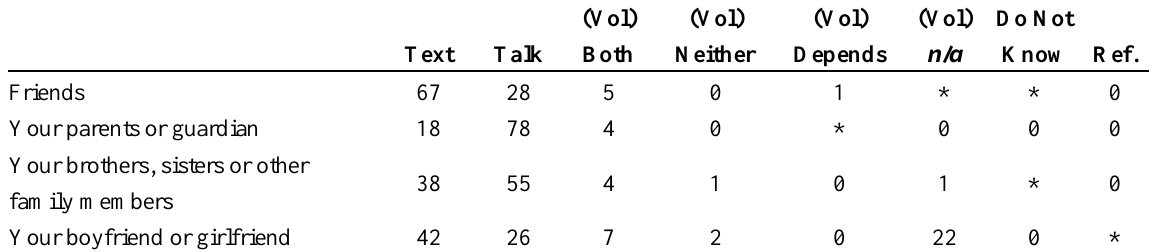
Table A5. When you want to reach [INSERT], are you more likely to use your cell phone to Text them or to Talk to them? (Based on teen cell users who text message [ N = 552]). a.